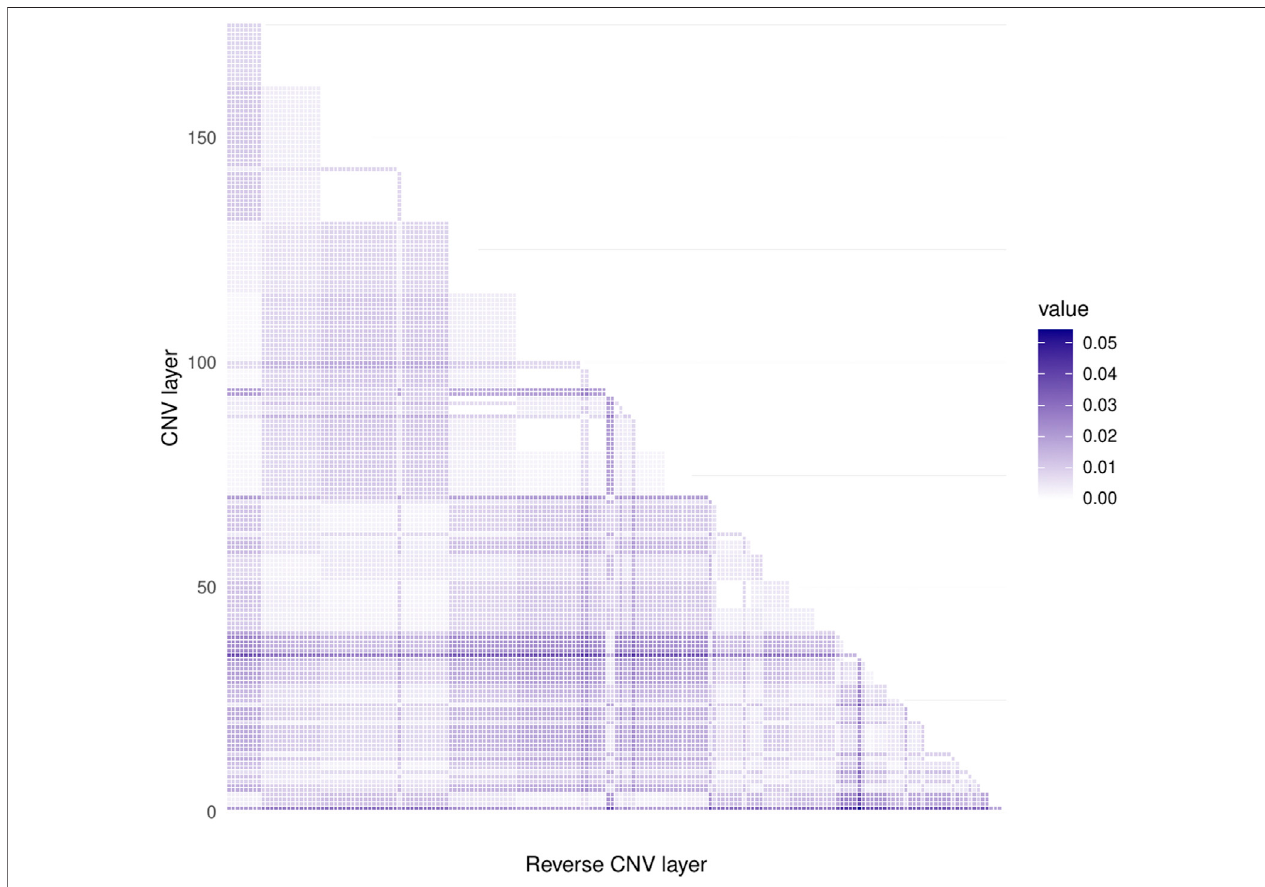
FIGURE 2 | Heatmap corresponding to the values of the D statistic for the Kolmogorov-Smirnov test. Both axes represent the same CNV layers. As it can be observe from the color code at the right part of the fi gure (very low values of D), none of the CNV layers present a larger KS statistics, which re fl ects that copy number alterations do not signi fi cantly change gene co-expression